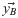
HF applied by both team members and their respective projections on the longitudinal axis of the box yB→.